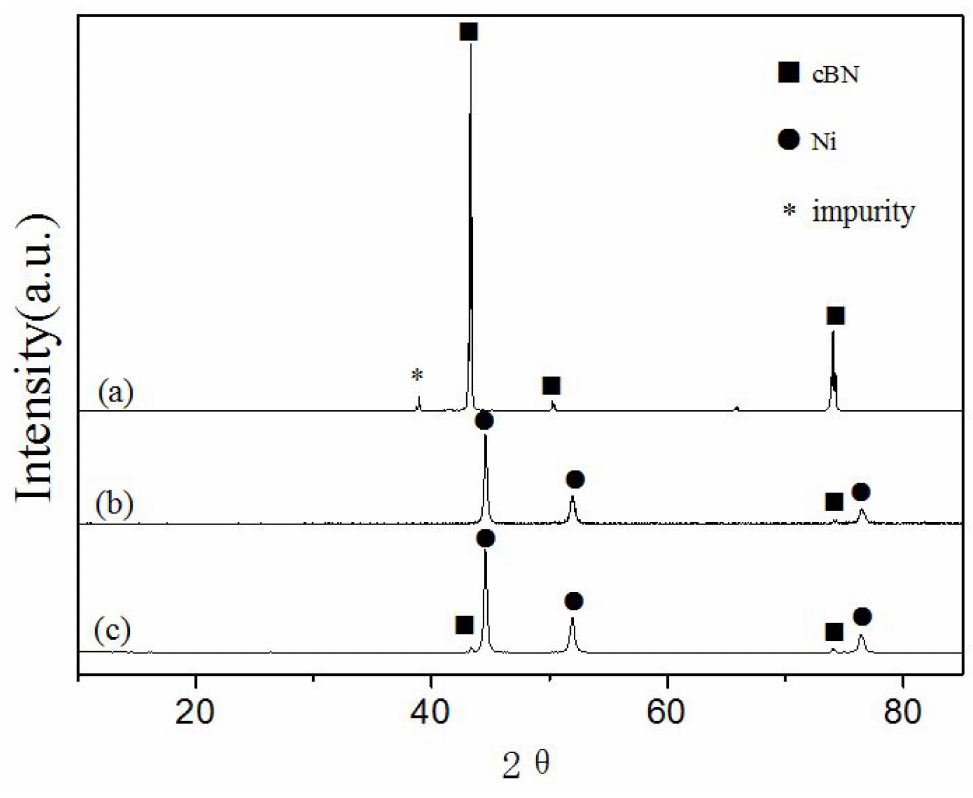
Figure 2. XRD patterns of: ( a ) raw cBN grains; ( b ) pure Ni plated cBN (S1); and ( c ) Ni/SiC plated cBN